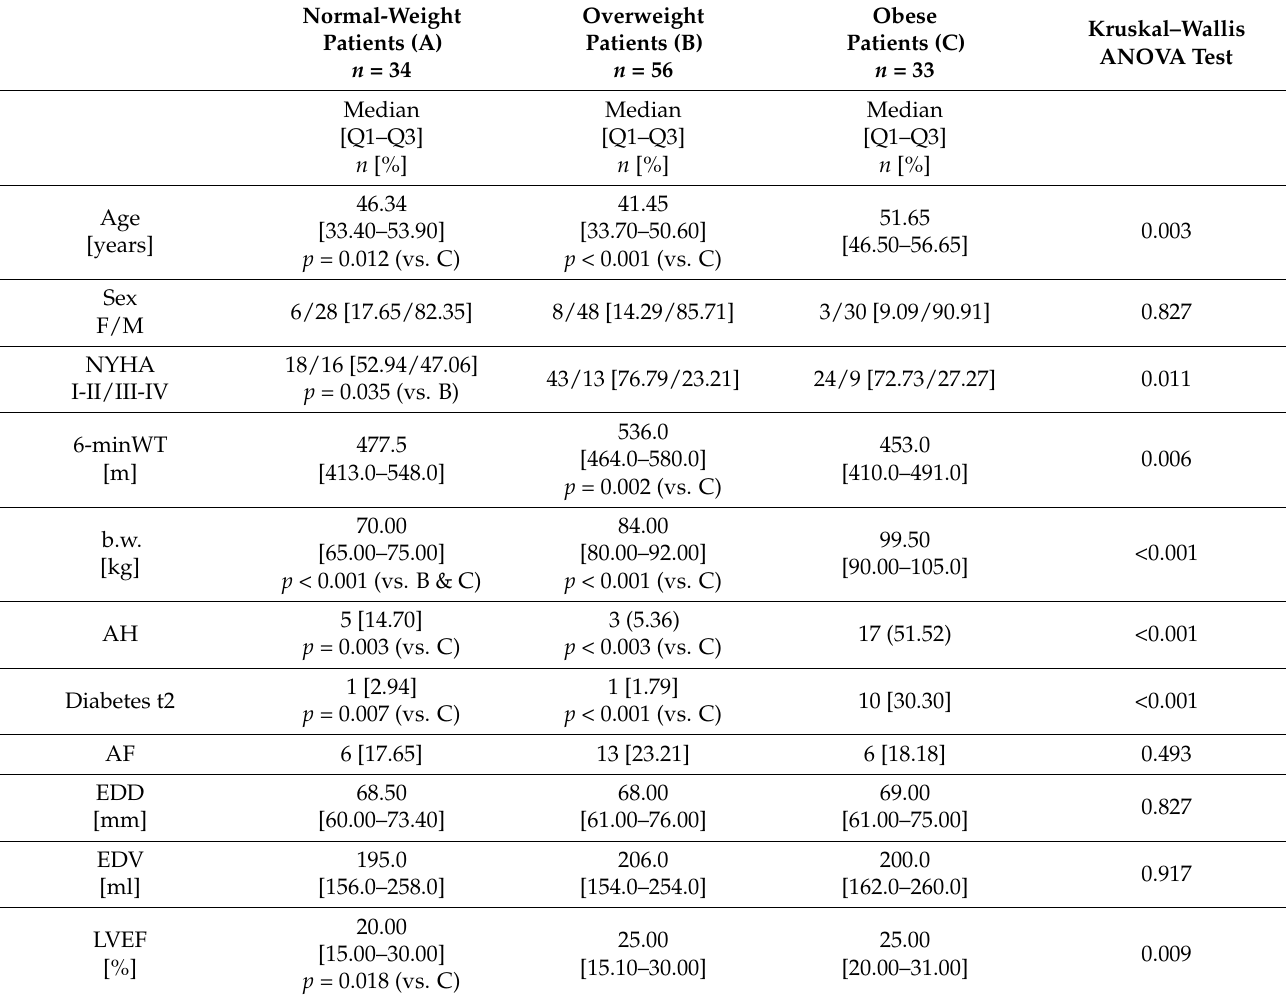
Table 1. The clinical characteristics of patients divided according to their